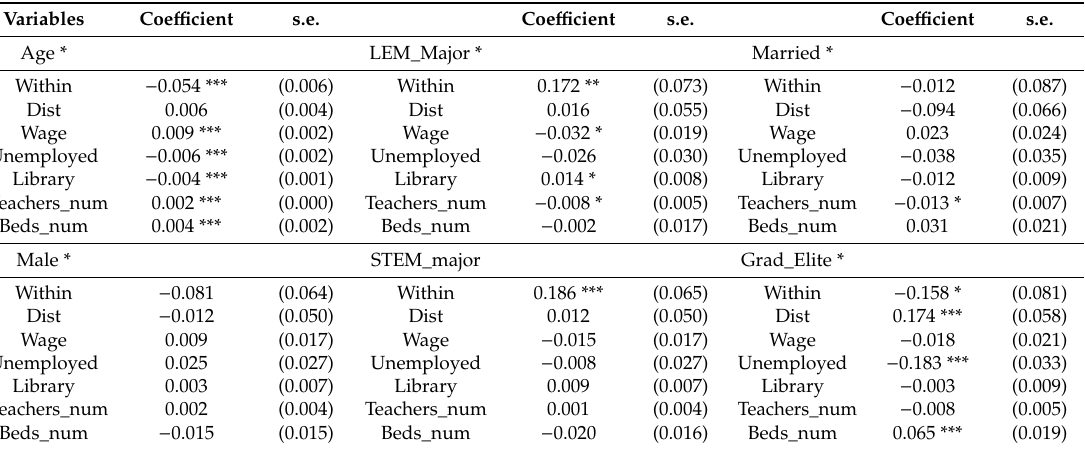
Table 4. regression results with interaction terms of Model